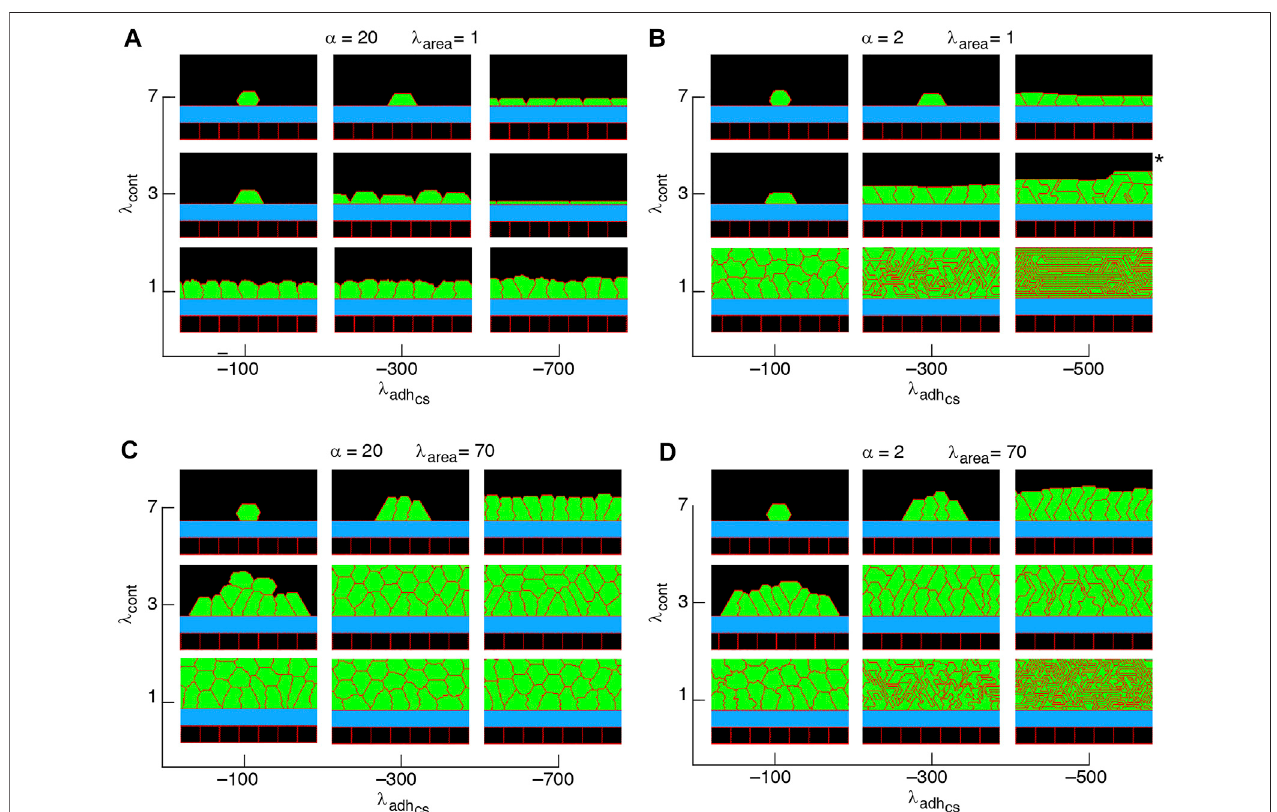
FIGURE 5 | Phase diagram of steady state collective cell morphology when the axis of division is perpendicular to the substrate, i.e., n div = (1, 0); see Eq. 3 (A – D) . α (cid:1) λ λ adh cs / adh cc . *Slow-growing multilayers. See Supplementary Movies S1